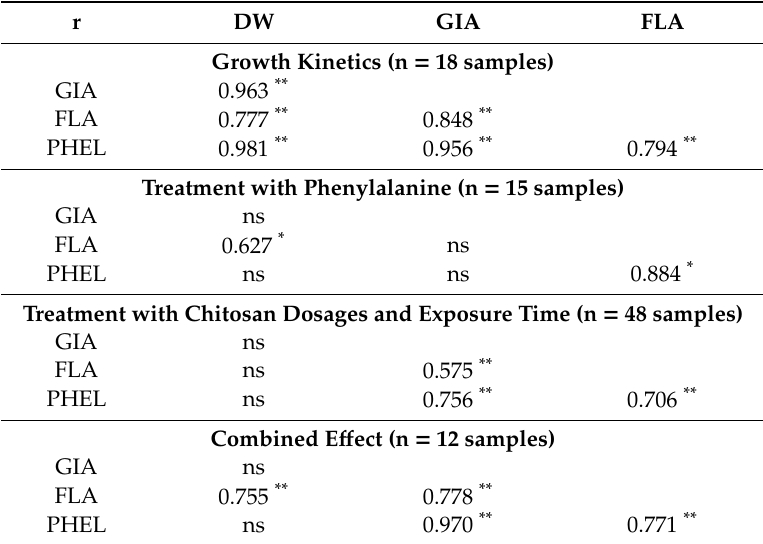
Table 3. Correlation analysis between the GIA, FLA and PHEL of AHRs with growth kinetics, various individual treatments, and the combined effect of phenylalanine and chitosan. r r DW